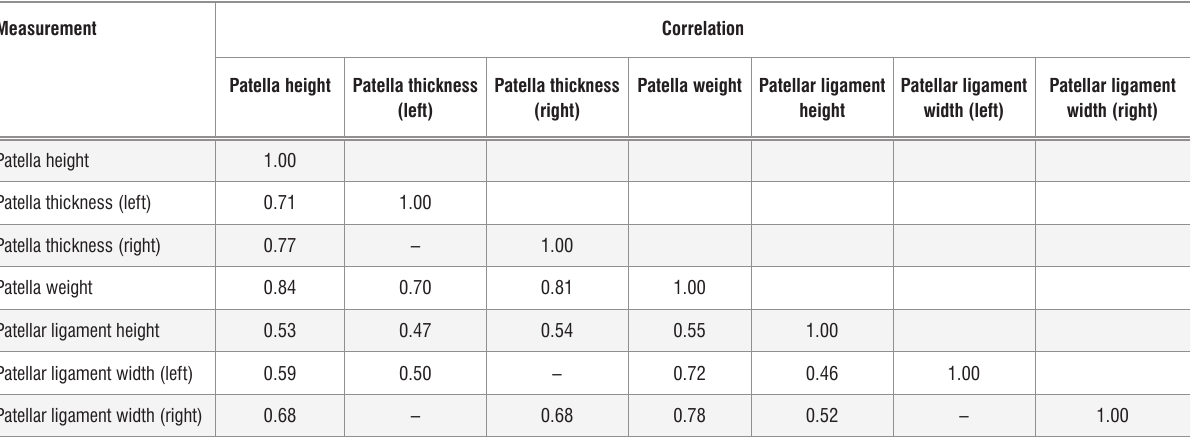
Table 5: Correlation coefficient between measurements of the patella and patellar ligament